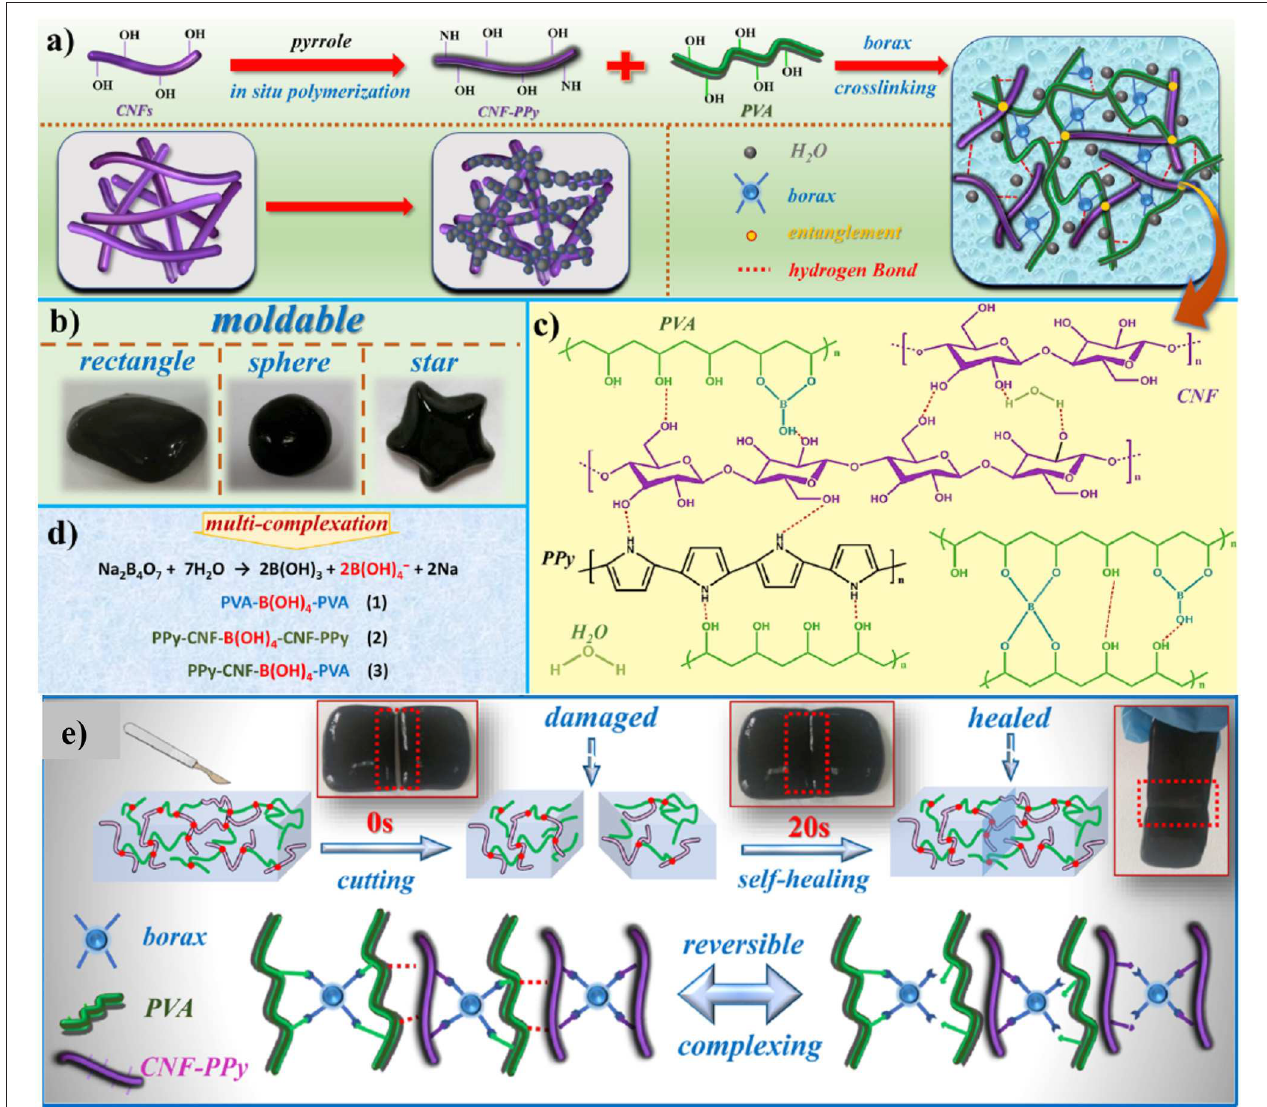
FIGURE 3 | (a) Schematic illustration of preparation and synthesis process of CNF–PPy/PB hydrogels. (b) CNF–PPy/PB hydrogels molded into various shapes. (c) Formation mechanism of the integrated 3D network within CNF–PPy/PB hydrogels. (d) Multi-complexation between PVA, CNF–PPy, and borax. (e) Schematic illustration of in situ self-healing and dynamic reversible cross-links of hydrogels (Ding Q. et al., 2018). Reproduced with the permission of 2018 American Chemical Society.